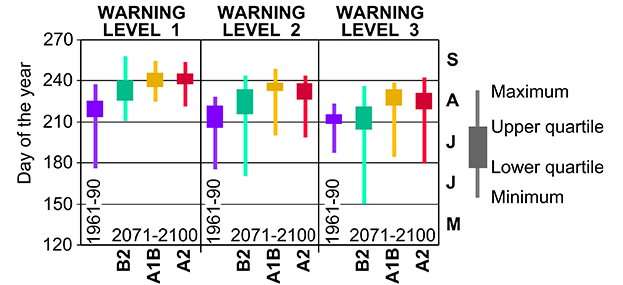
Fig. 6. Simulated last occurrences of heat wave warning levels for 1961–1990 and for 2071–2100 according to three different emis- sions scenarios. M, J, J, A, and S on the right indicate May, June, July, August, and September,